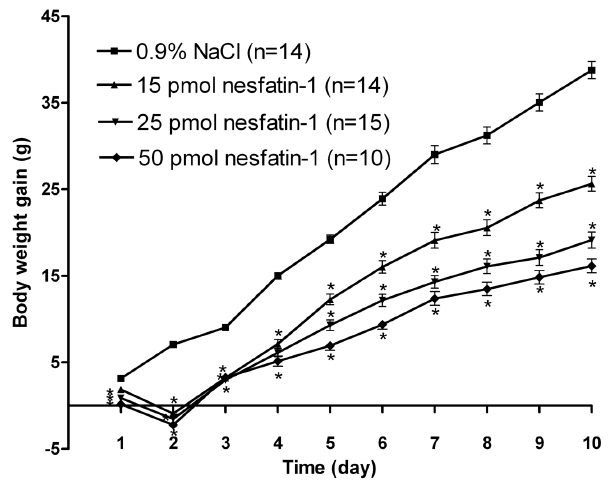
Figure 2. Change in body weight gain after continuous injection of nesfatin-1 for 10 days. Body weight gain (increment from day 0) in rats after nesfatin-1 injection (15, 25, or 50 pmol daily). Data are mean 6 SEM *, P , 0.01 compared with vehicle.